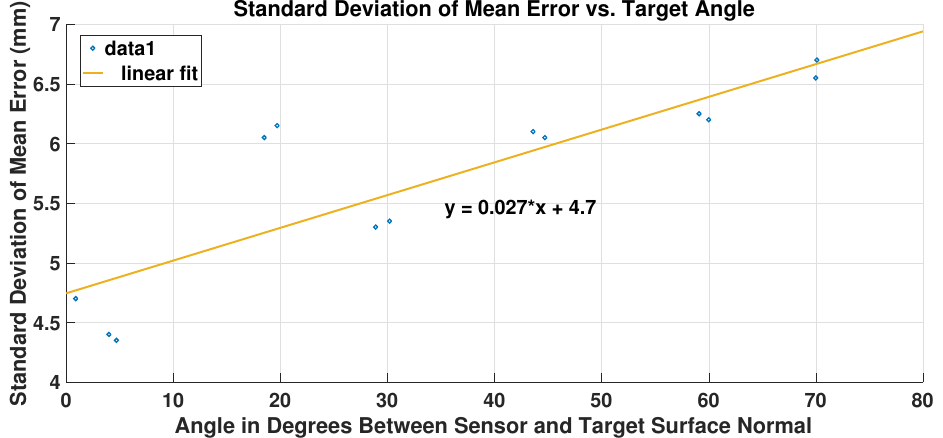
Figure 16. Standard deviation of range w.r.t. angle